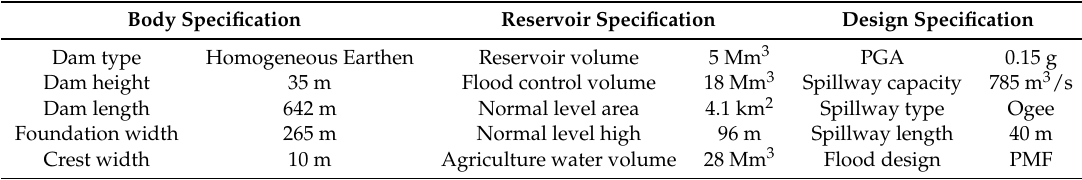
Table 1. General characteristics of the Boostan Dam. PMF: probable maximum